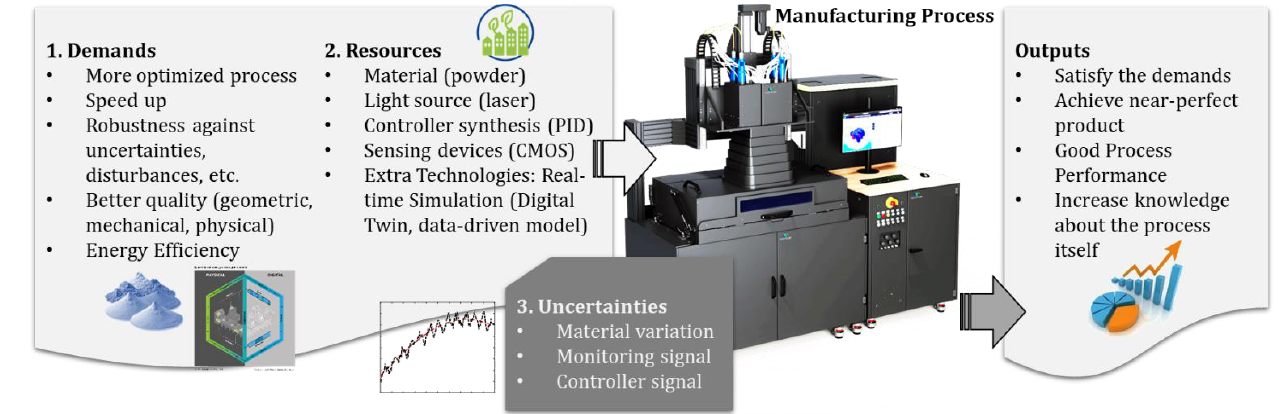
Figure 3. Novel concept of robust AM, with uncertainties being pointed